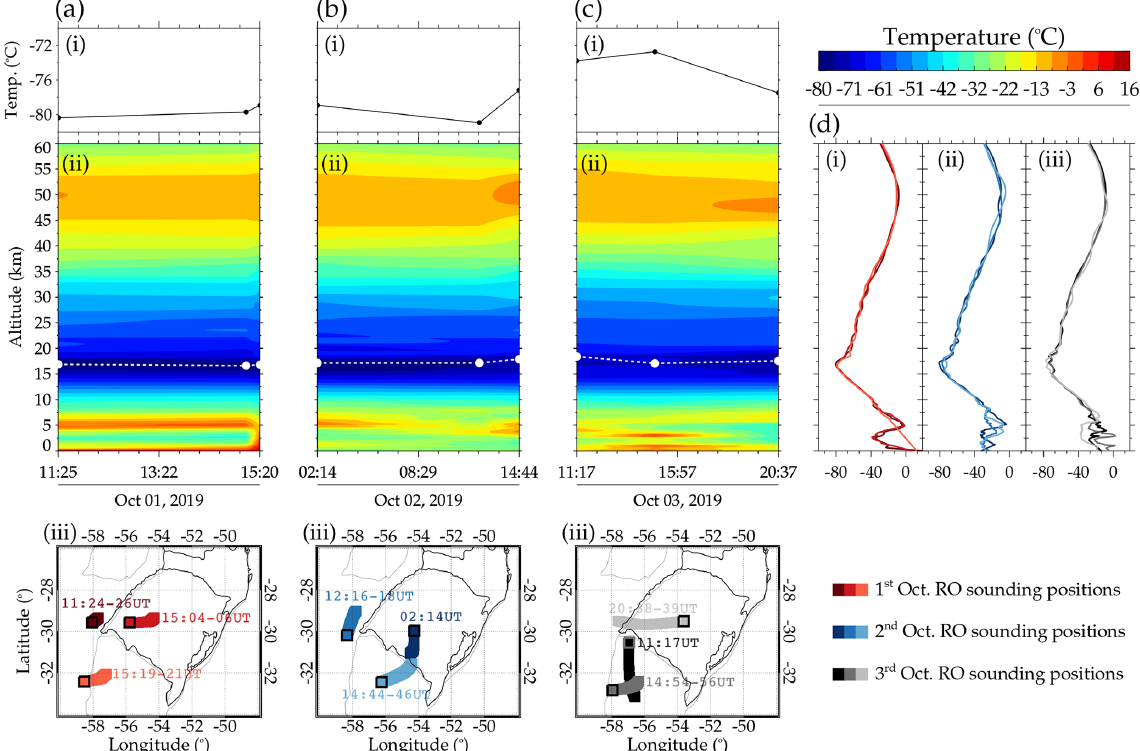
Figure A1. Radio occultation sounding profiles around the SMS observatory from 1 to 3 October 2019 before, during, and after the CGW